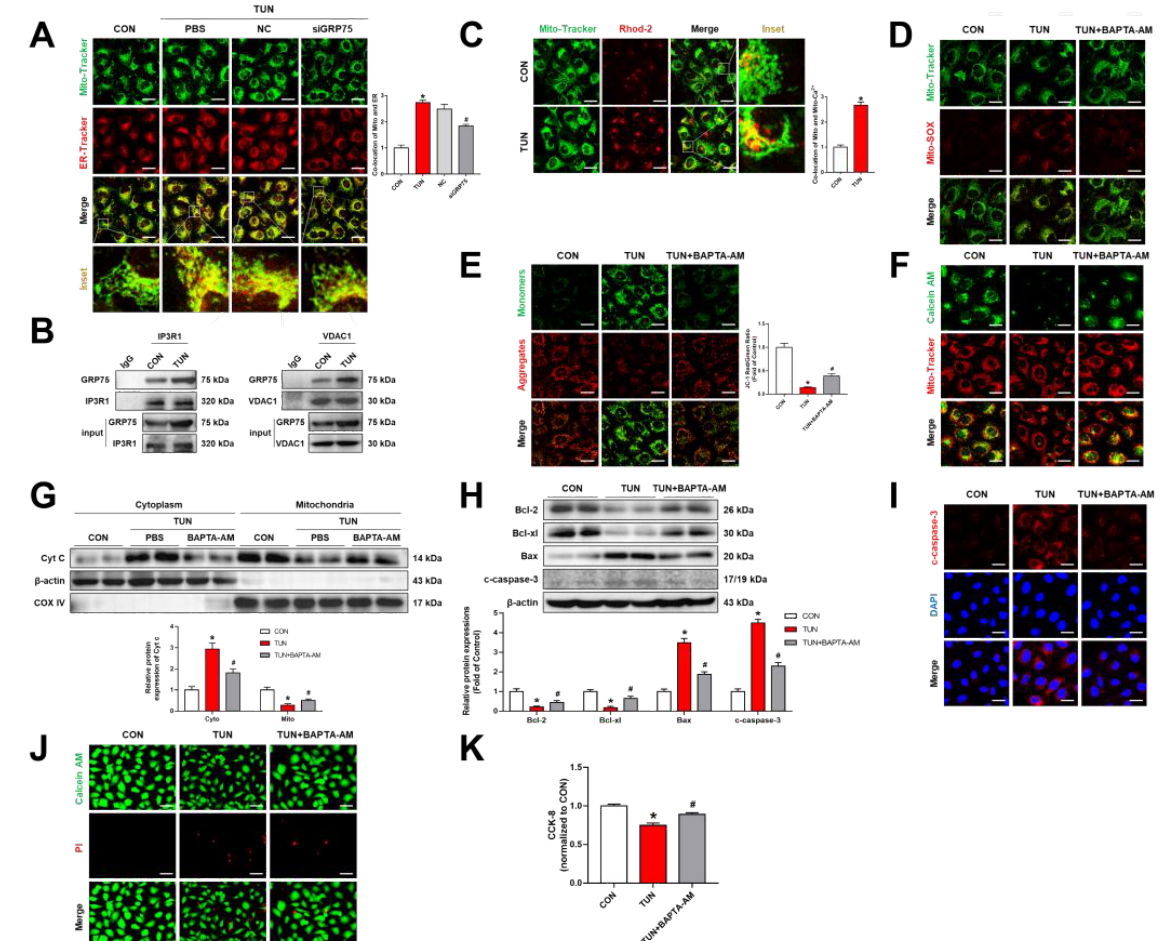
Figure 5. ERS induced ER–mitochondrial coupling, leading to mitochondrial dysfunction and cell apoptosis. RMECs were transfected with GRP75 siRNA for 48 h and incubated with TUN (5 µ g/mL) for 24 h. ( A ) Mito-Tracker Green (200 nM, 30 min) and ER-Tracker Red (1 µ M, 30 min) were used to determine co-localizations of the mitochondria and ER. ( B ) Co-immunoprecipitation analysis of GRP75 interactions with IP3R1 or VDAC1 in RMECs. ( C , D ) Mitochondrial Ca 2+ and mitochondrial ROS were detected by Rhod-2 AM (2 µ M, 30 min) and MitoSOX™ Red (5 µ M, 10 min). Mito-Tracker Green (200 nM, 30 min) was used to co-localize the mitochondria. ( E ) Mitochondrial membrane potential was assessed by JC-1 staining. ( F ) Mitochondrial permeability transition pores (mPTPs) were detected using a Calcein-AM dye (2 µ M) containing CoCl 2 (250 µ M) for 45 min. ( G ) Cyt c expressions in mitochondrial and cytosolic fractions were detected by Western blotting. ( H ) Apoptosis-related proteins (Bcl-2, Bcl-xl, Bax, and cleaved caspase-3) were evaluated by Western blotting. ( I ) cleaved caspase-3 was performed in a representative immunofluorescence assay. ( J ) Live cells (green, Calcein-AM, 2 µ M, 30 min) and dead cells (red, PI, 5 µ M, 30 min) were probed through the use of a Calcein-AM/PI double staining kit. ( K ) BAPTA-AM rescued TUN-induced cell damage, as determined by the CCK-8 assay. Data are presented as means ± SD. * p < 0.05 vs. control group, # p < 0.05 vs. HG or AGEs group.